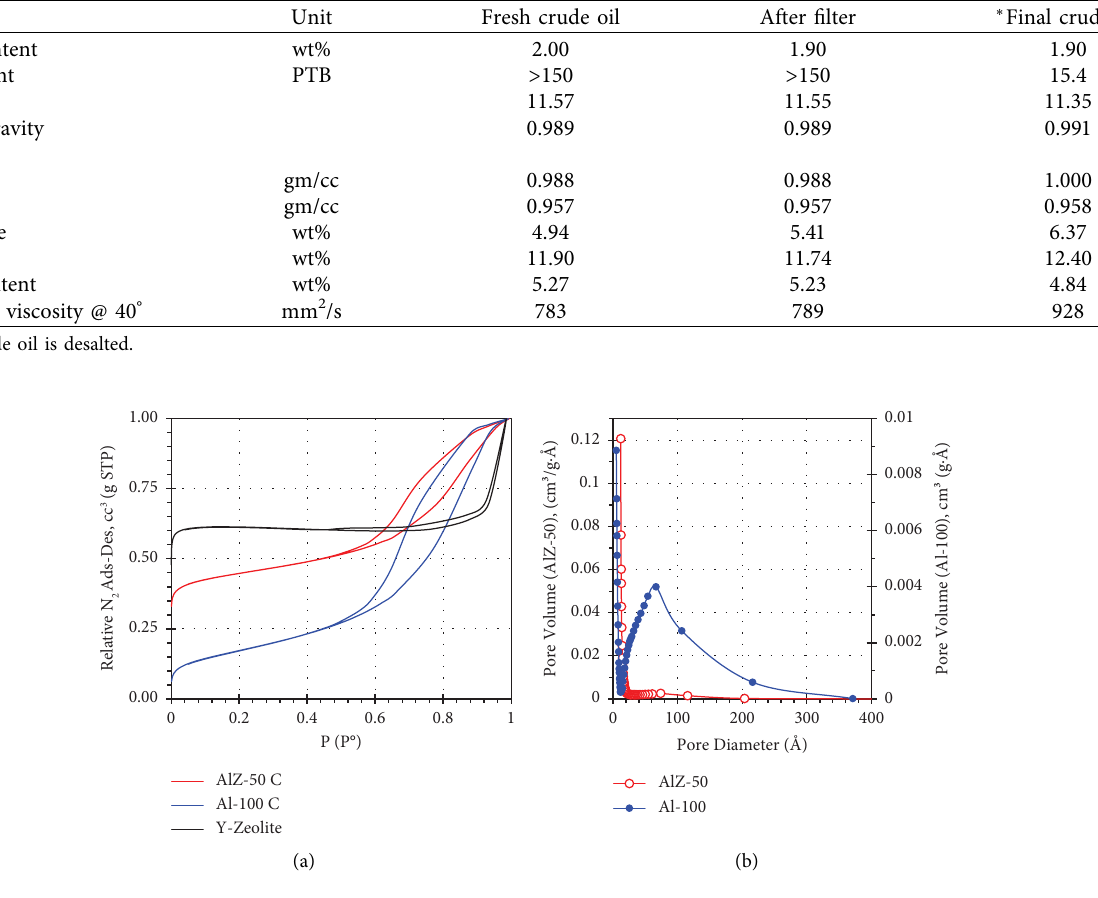
Figure 3: N 2 adsorption-desorption isotherm and pore distribution.